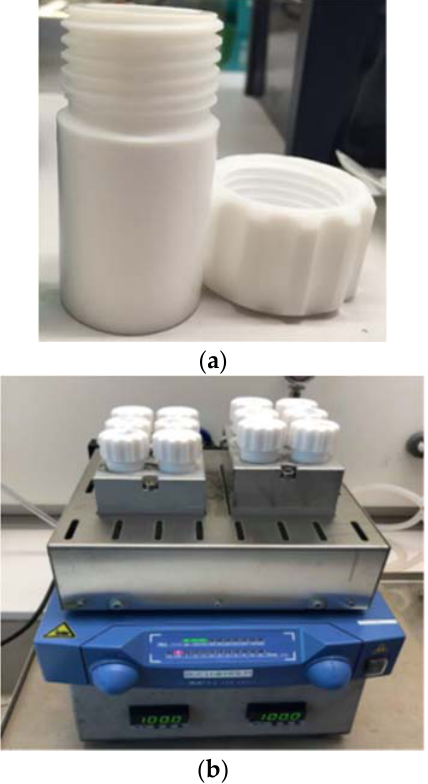
PTFE ‐ vial used for digestion. Figure 1. ( a ) A PTFE-vial used for digestion. ( b ) PTFE vials in the incubator. The picture shows